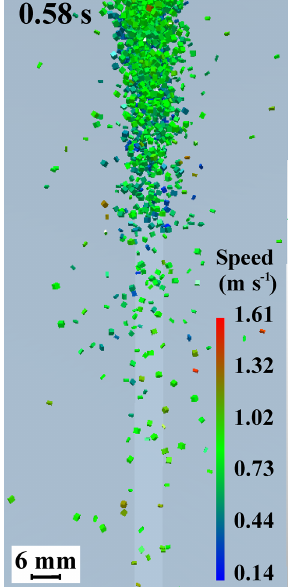
Figure 8. Flow front seen from above 0.58 s after the gate removal. The saltating particles of the distal distribution in front of the dense granular flow are clearly identifiable. In this example the granular mass is 26g, the grain size is 1mm, w is 6mm and θ is 27 ◦ .